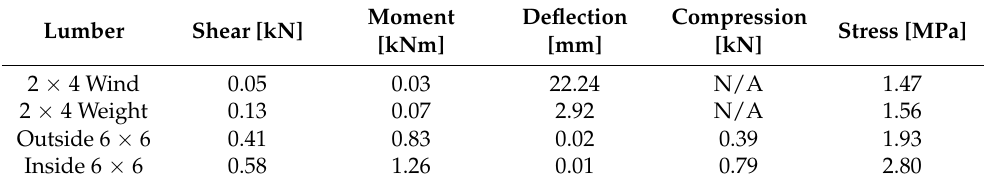
Table A1. Forces, deflections and stresses of structural members.